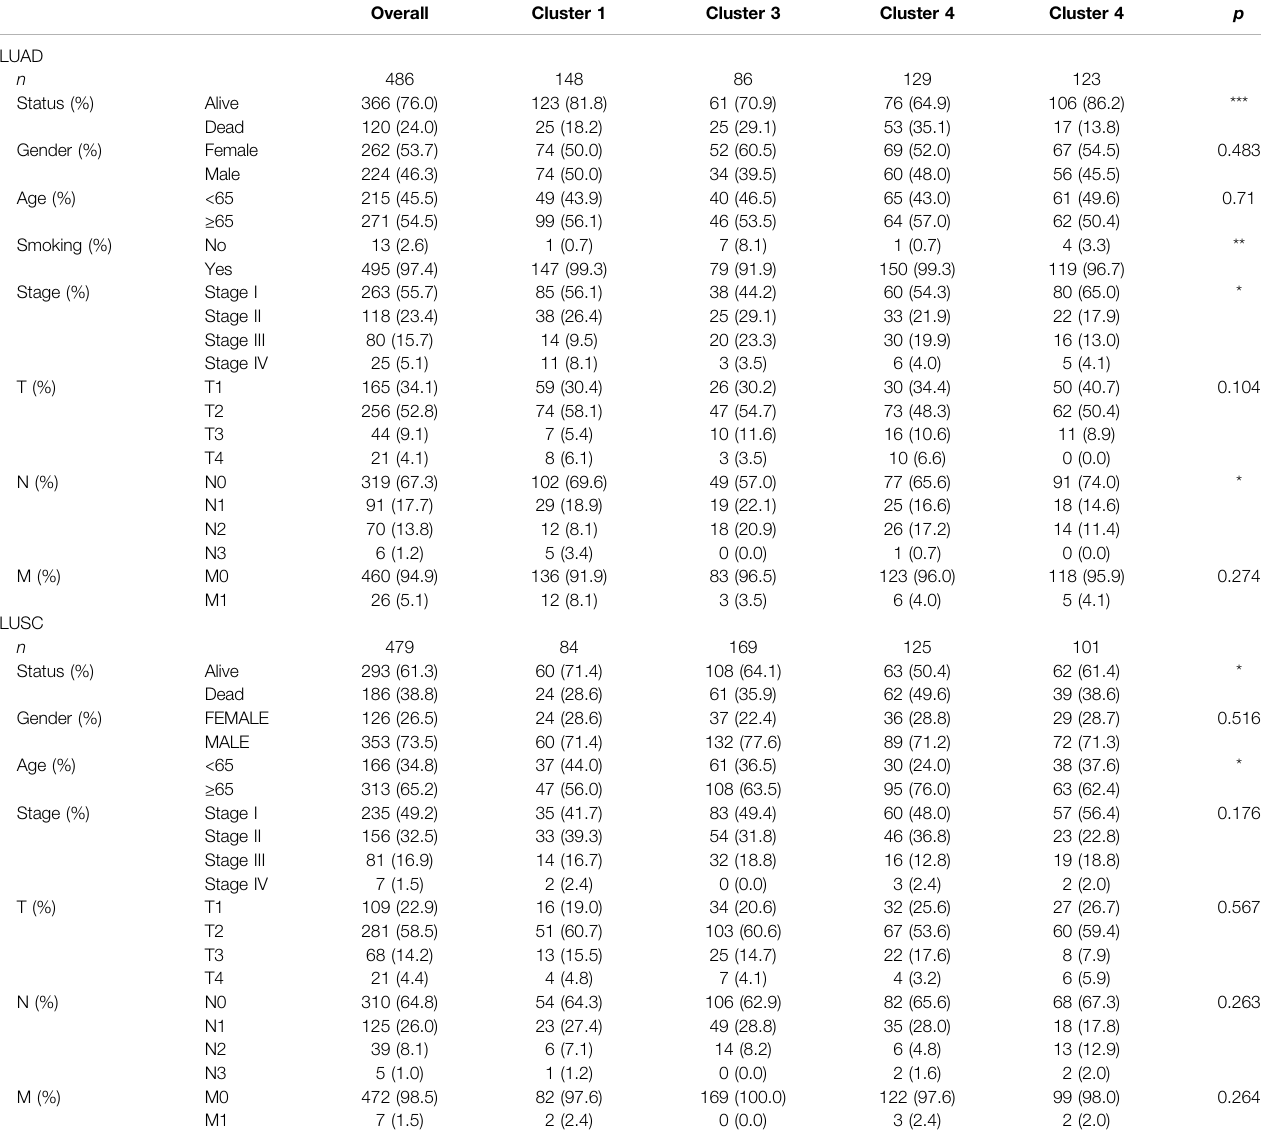
TABLE 2 | The correlation analysis of clinical traits and m6A clusters from TCGA-LUAD and LUSC.